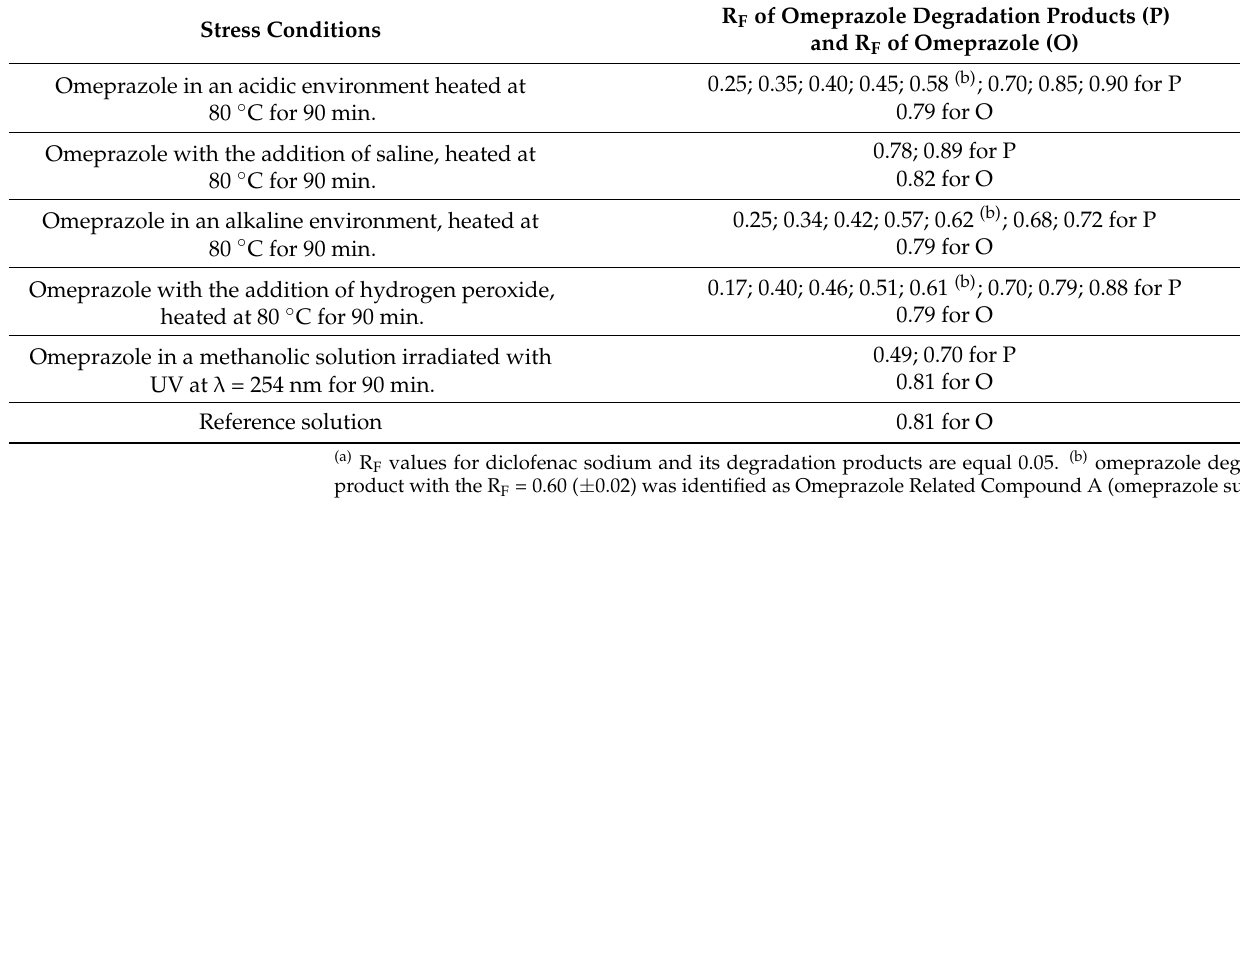
Table 2. R F values for omeprazole and omeprazole degradation products, R F values for diclofenac and diclofenac degradation products (a) after analysis on silica gel using the chloroform–methanol– ammonia (36:4:0.60, v / v / v